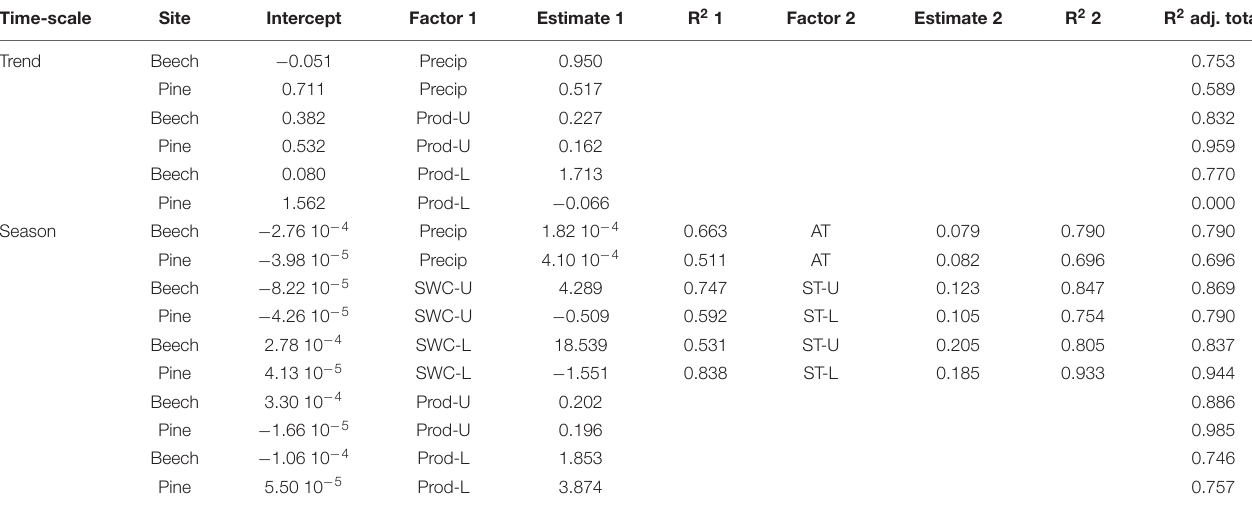
TABLE 4 | Generalised linear model (GLM) output for the trend and the seasonal component from a time series decomposition of CO 2 efflux (g C m − 2 d − 1 ) using precipitation [Precip (mm d − 1 )], SWC (m 3 m − 3 ), air temperature (AT) ( ◦ C), soil temperature (ST) ( ◦ C), and CO 2 production (Prod) (g C m − 3 d − 1 ) in the upper (–U) or lower (–L) soil layers as predictors.